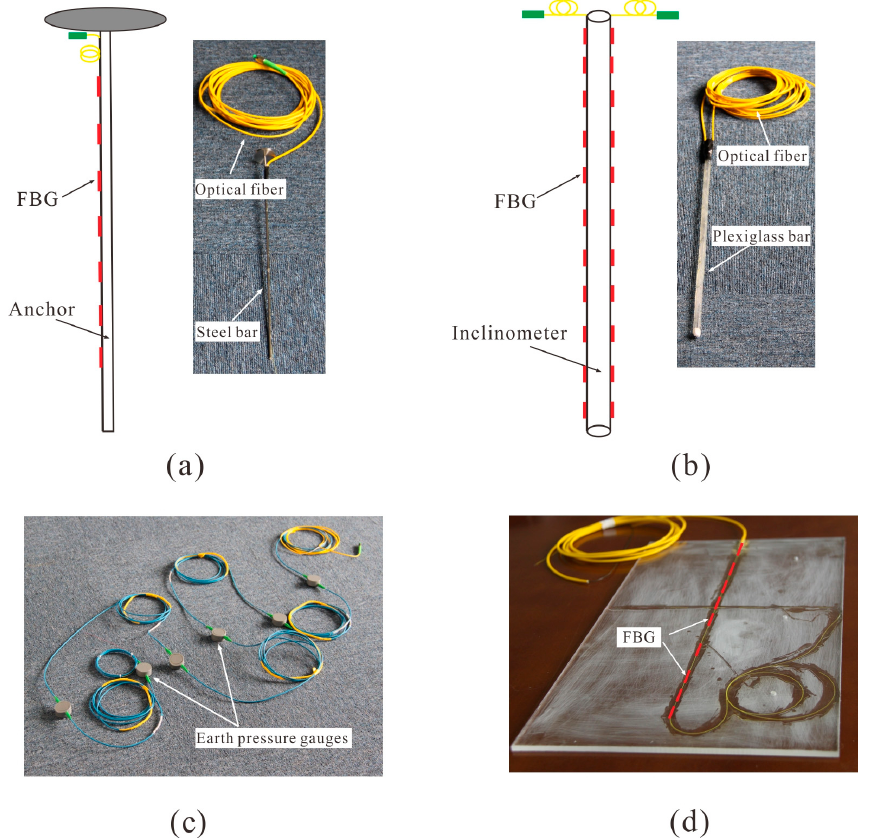
Figure 3. Developed sensors: ( a ) Anchors ( b ) Inclinometer pipe ( c ) Earth pressure gauges ( d ) Retaining wall.